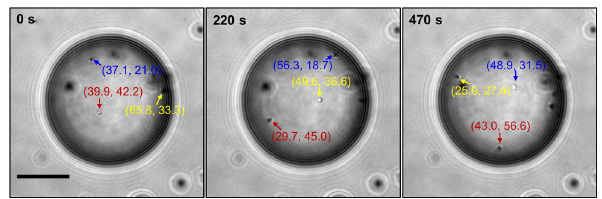
Figure 1. Optical images from typical bead-mobility experiments for a toluene-derived SOM particle (toluene sample 8 in Table 1) at 80%RH. Three different beads are labeled using colored arrows. The x and y coordinates of these beads are also indicated. Scale bar: 20µm.